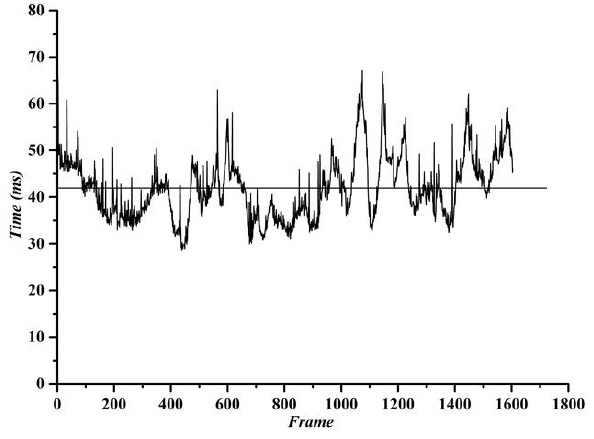
Figure 12. Time of algorithm running.